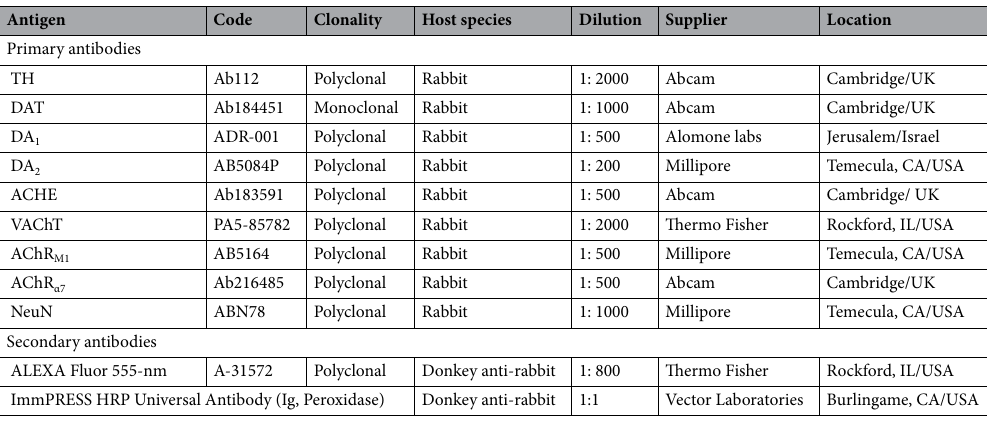
Table 3. Specification of